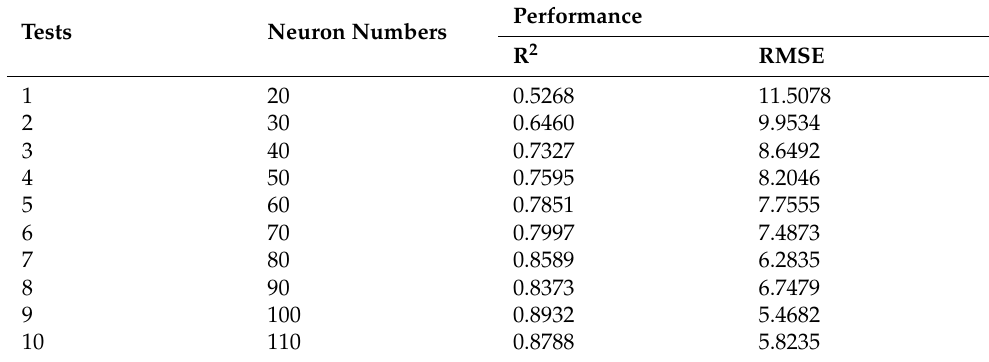
Table 4. Performance of an ELM model with different neuron numbers.